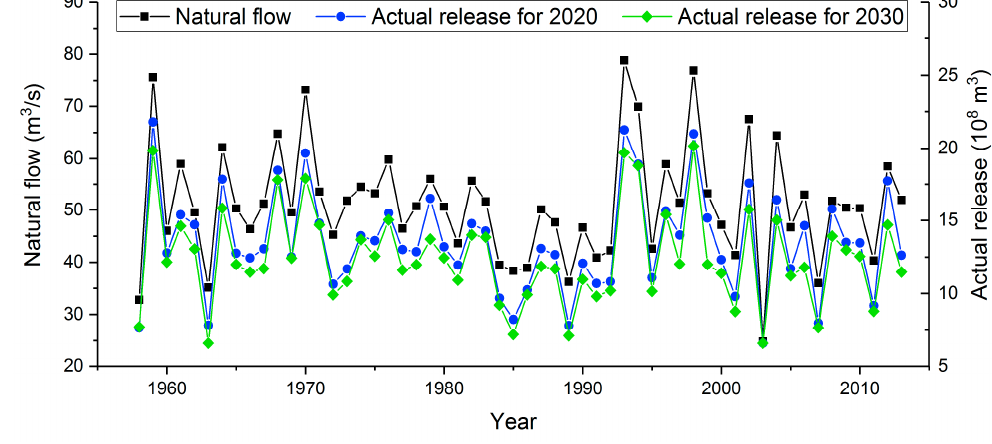
Figure 5. Long serial changes of natural flow and actual release.